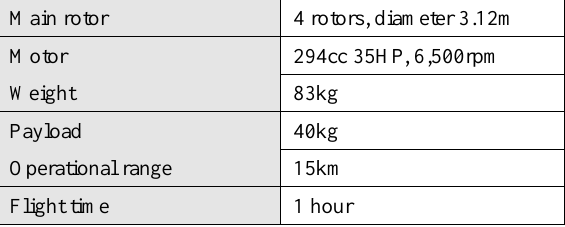
Table 1. Specifications of the